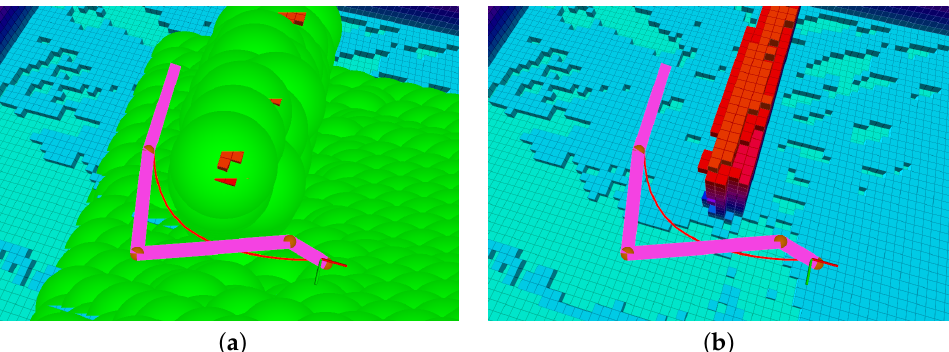
Figure 12. Dynamic Local Obstacle Mapping and Avoidance. In ( a ) the DLOM is made visible while in ( b ) it is